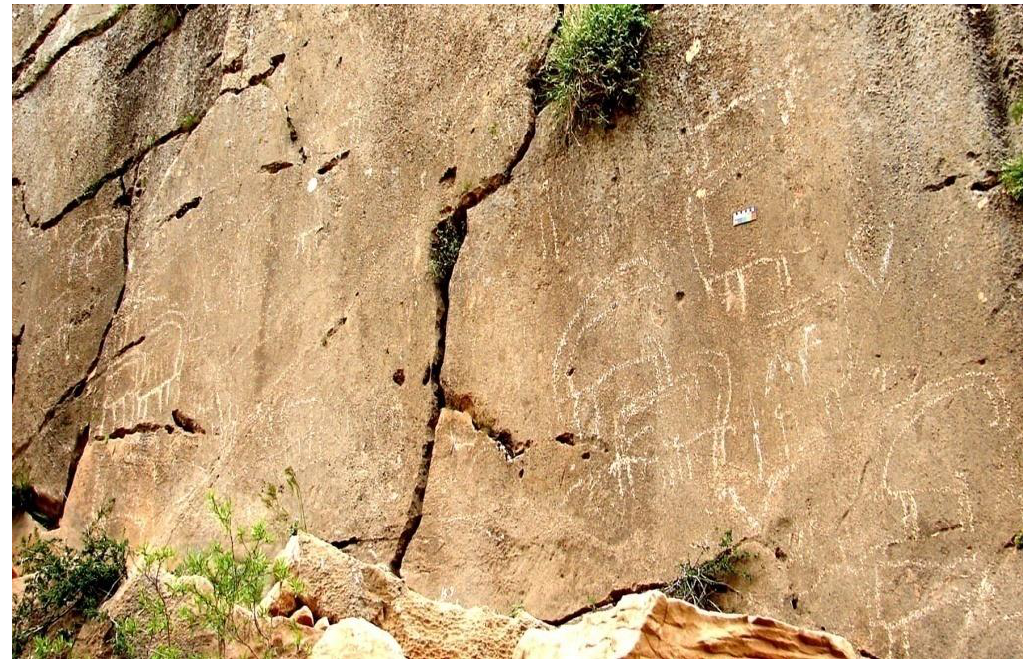
Figure 7. “Antelopes” with long horns on Havar Poineh rock at Paveh.